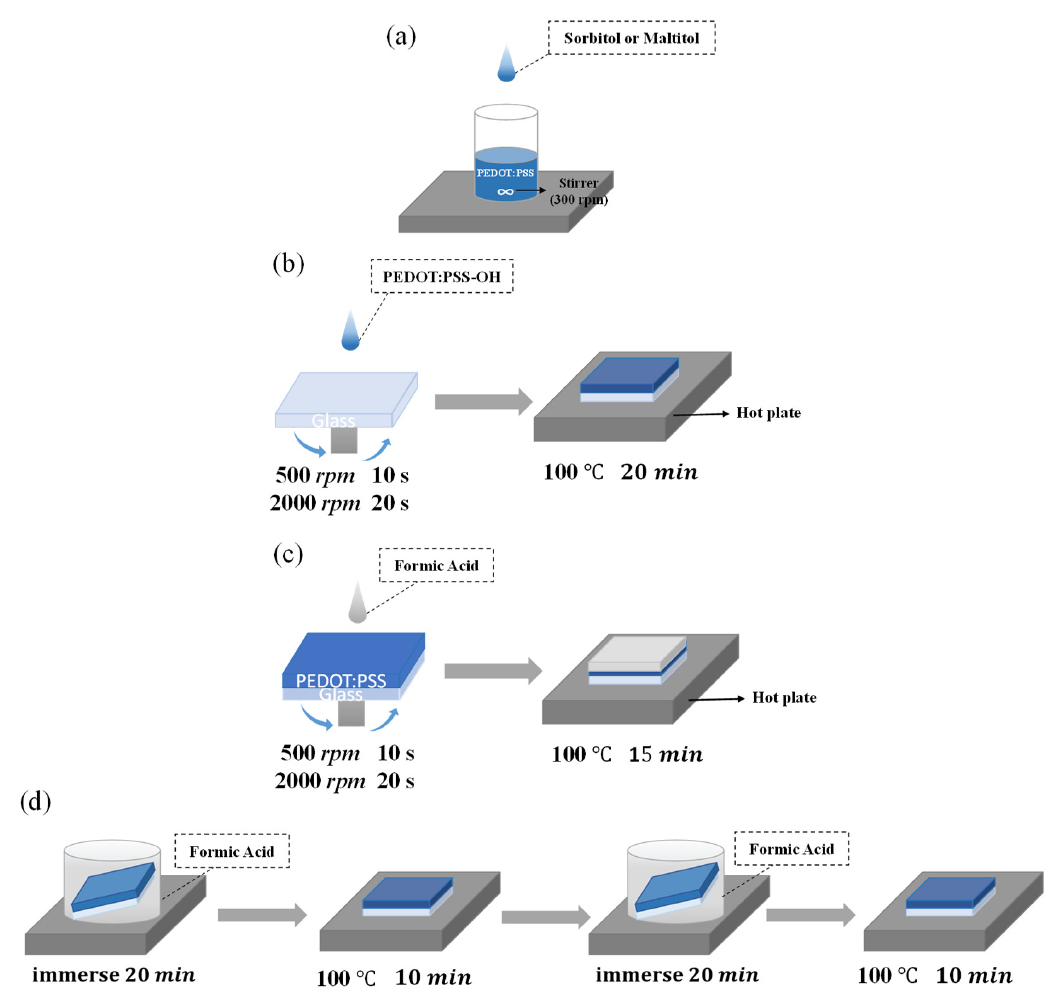
Figure 1. ( a ) Organic additive was doped in PEDOT: PSS. ( b ) The PEDOT: PSS was coated on the glass substrate and baked on a hot plate at 100 °C for 20 min. ( c ) The FA was coated on the PEDOT: PSS film, which was named acid treatment. ( d ) The PEDOT: PSS film was immersed in FA for about 20 min, which was named multi-acid treatment.